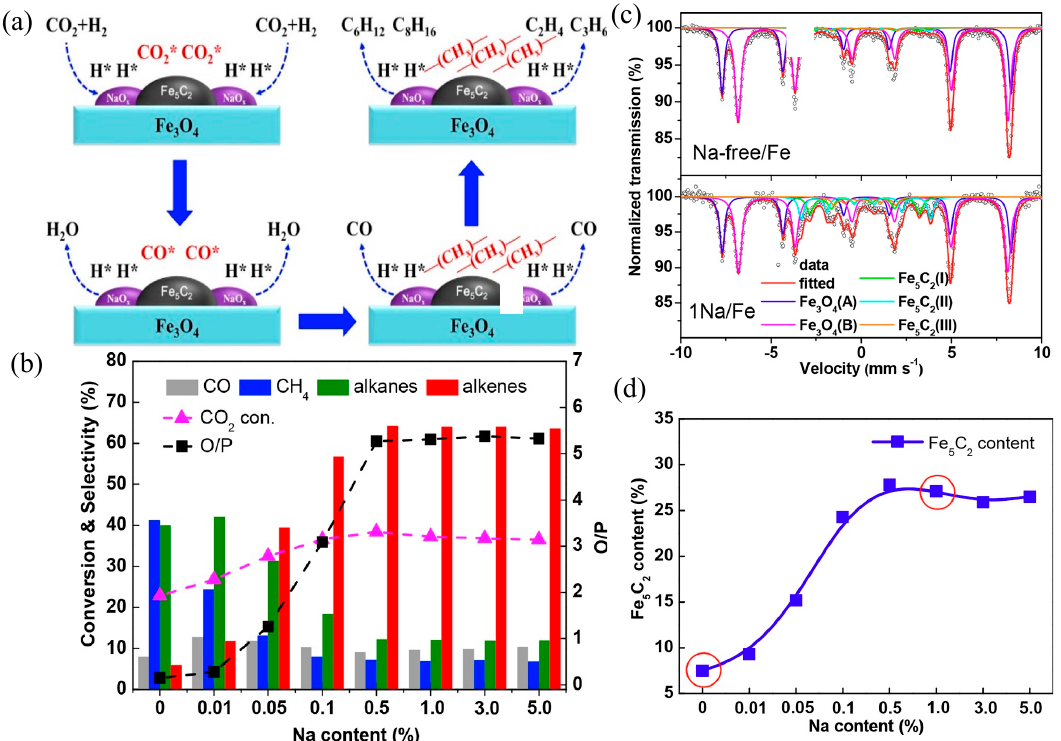
Figure 9. ( a ) Illustrated scheme of CO 2 hydrogenation. ( b ) Conversion and selectivity of CO 2 hydrogenation over an xNa/Fe catalyst (testing conditions: H 2 /CO 2 molar ratio = 3; P = 3 MPa; T = 593 K; GHSV = 2040 mL h − 1 g cat − 1 ; TOS = 10 h). ( c ) Mössbauer spectra of the spent Na-free/Fe and 1Na/Fe catalysts. ( d ) Fe 5 C 2 content of the spent xNa/Fe catalyst vs. the Na content. Adapted with permission from ref. [98]. Copyright 2019 American Chemical Society.